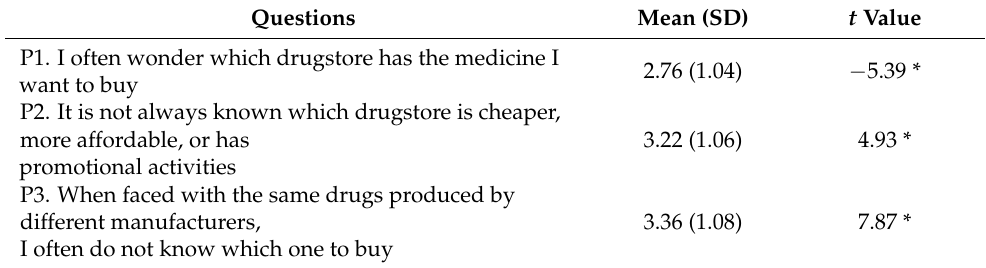
Table 2. Possibly problematic situations concerning drug purchasing